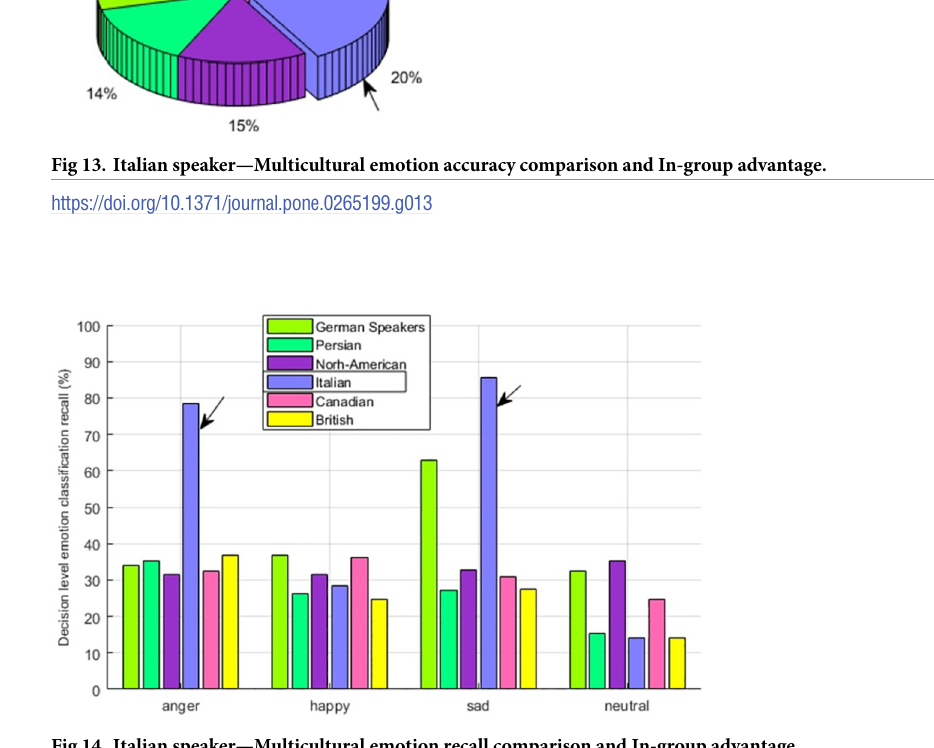
Fig 14. Italian speaker—Multicultural emotion recall comparison and In-group advantage.